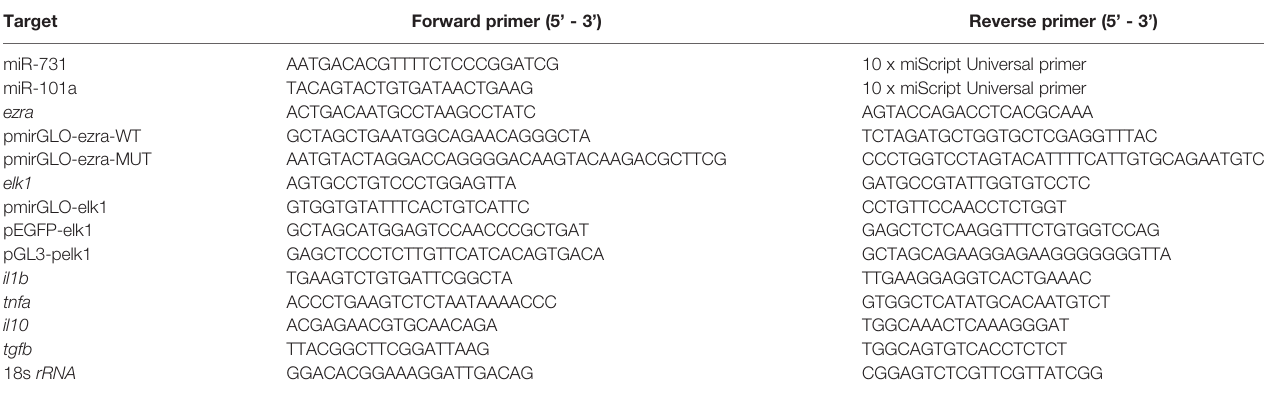
TABLE 1 | Primers used in the present